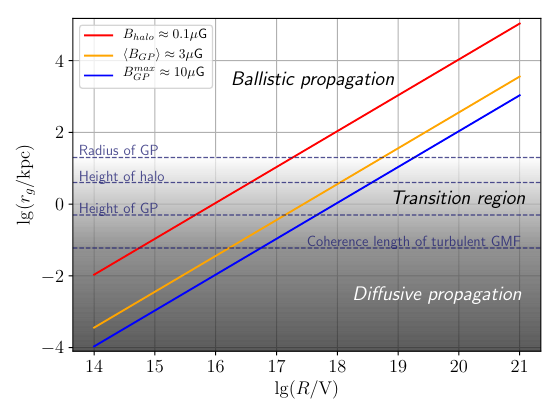
Figure 1: Gyro radius r g as a function of rigidity R for various magnetic field strengths B (indicated in legend), along with relevant length scales (horizontal